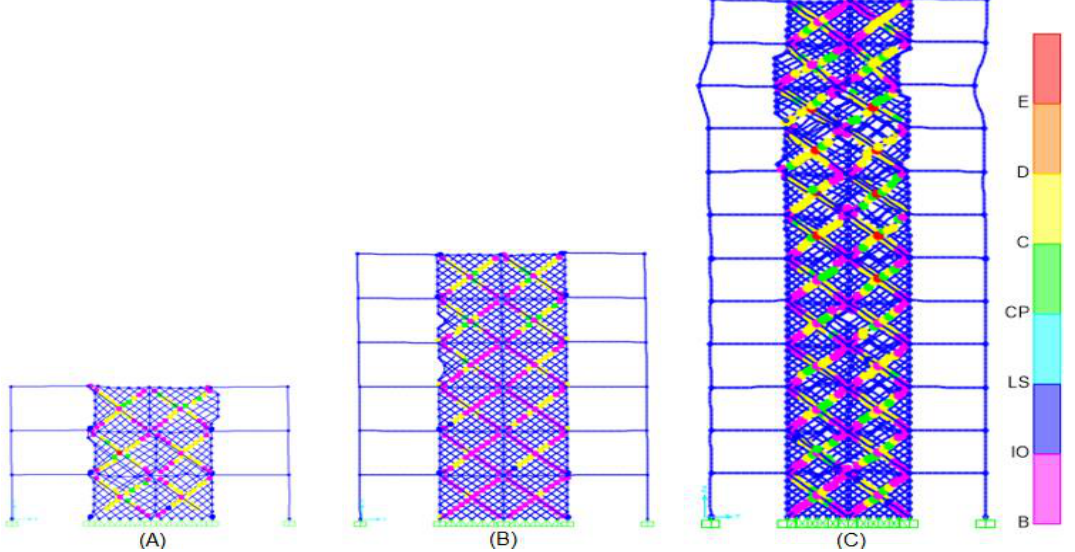
Fig. 11. Three samples of the plastic hinges created in the frames braced with the steel wall of 3 (A), 6 (B) and 12-story (D)